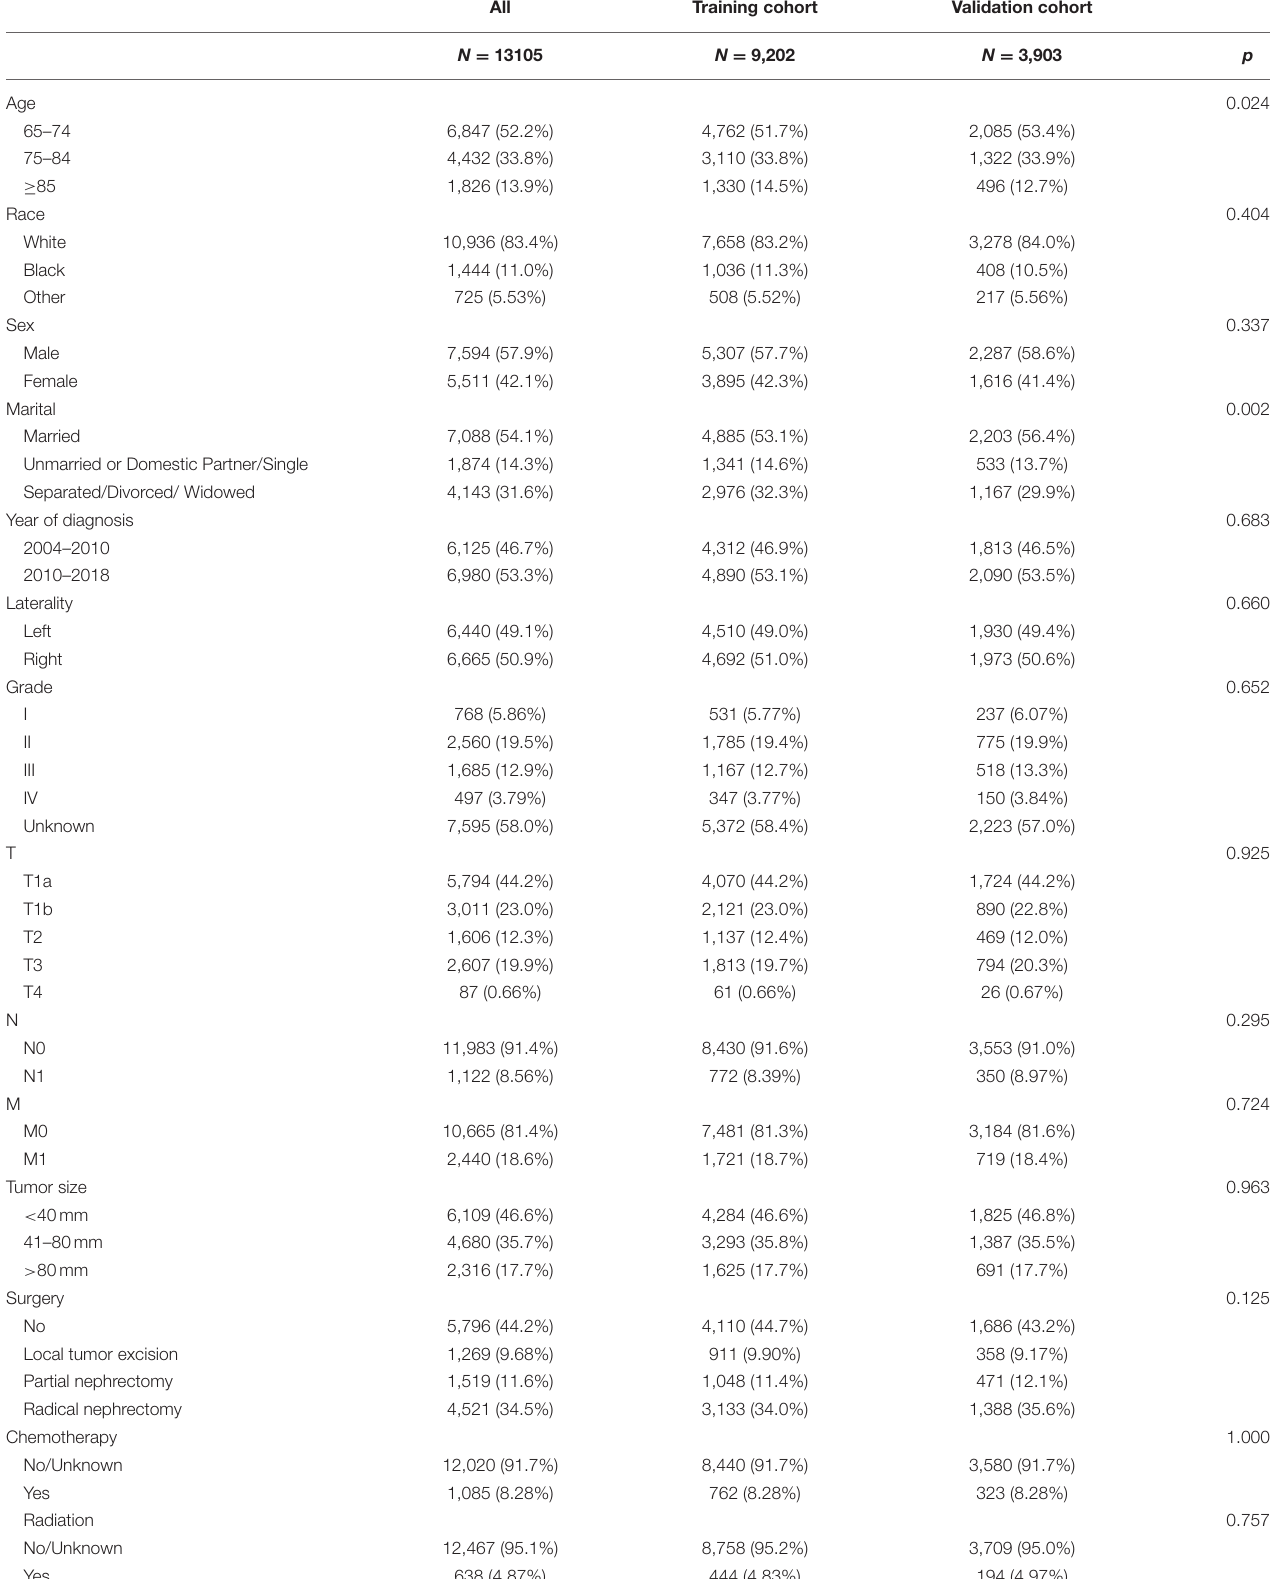
TABLE 1 | Clinicopathological characteristics of elderly patients with